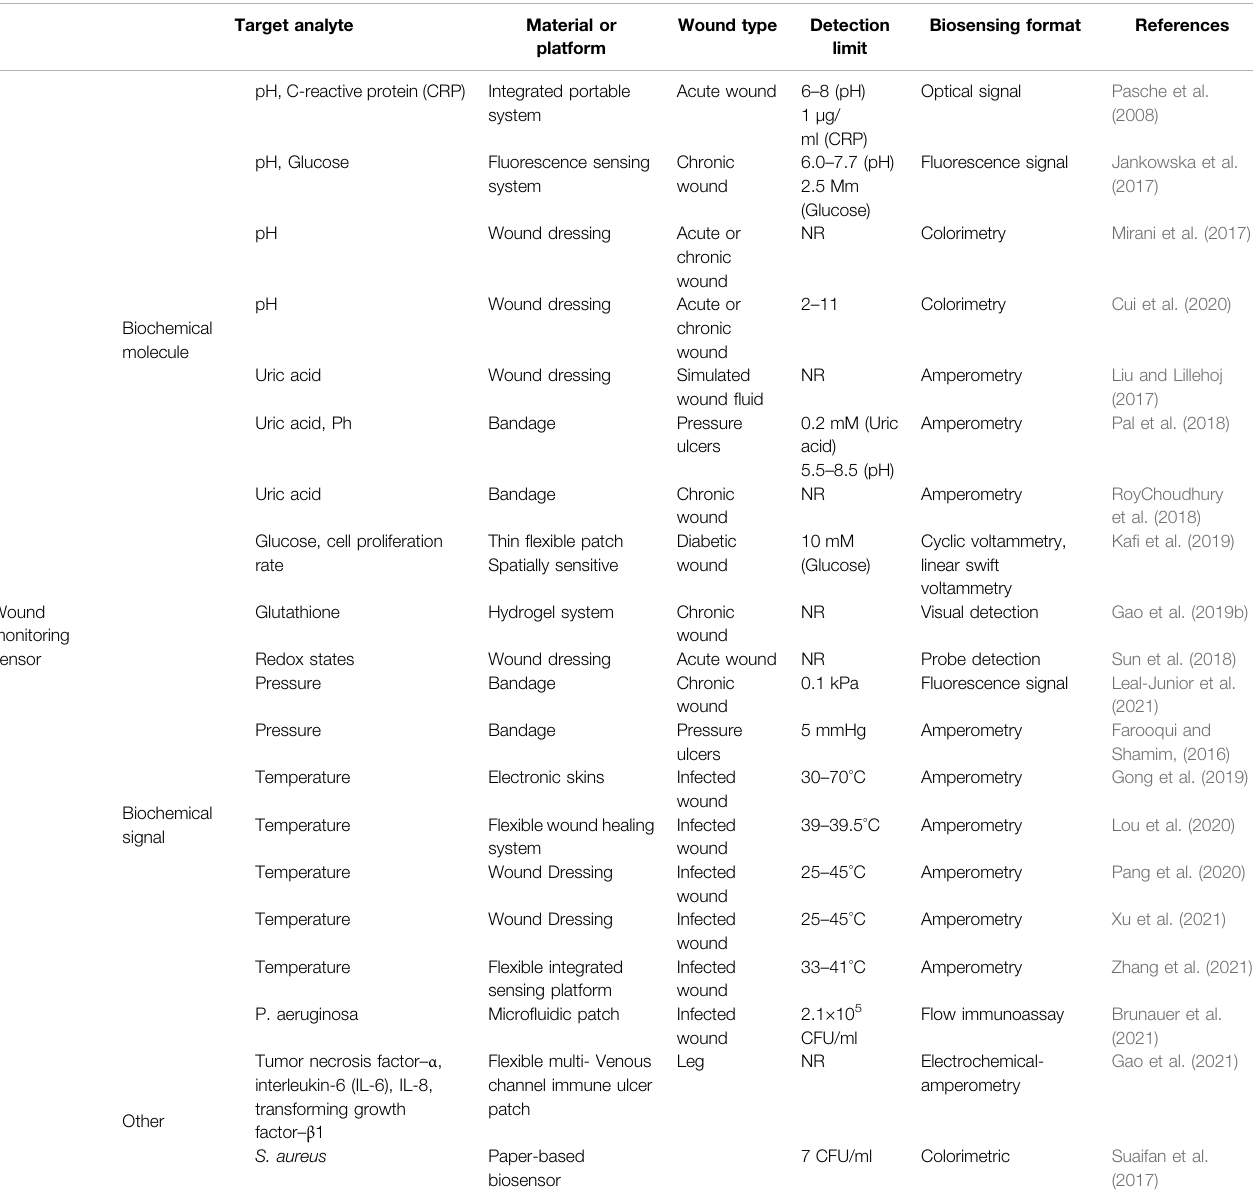
TABLE 3 | Representative new intelligent sensor platforms for wound